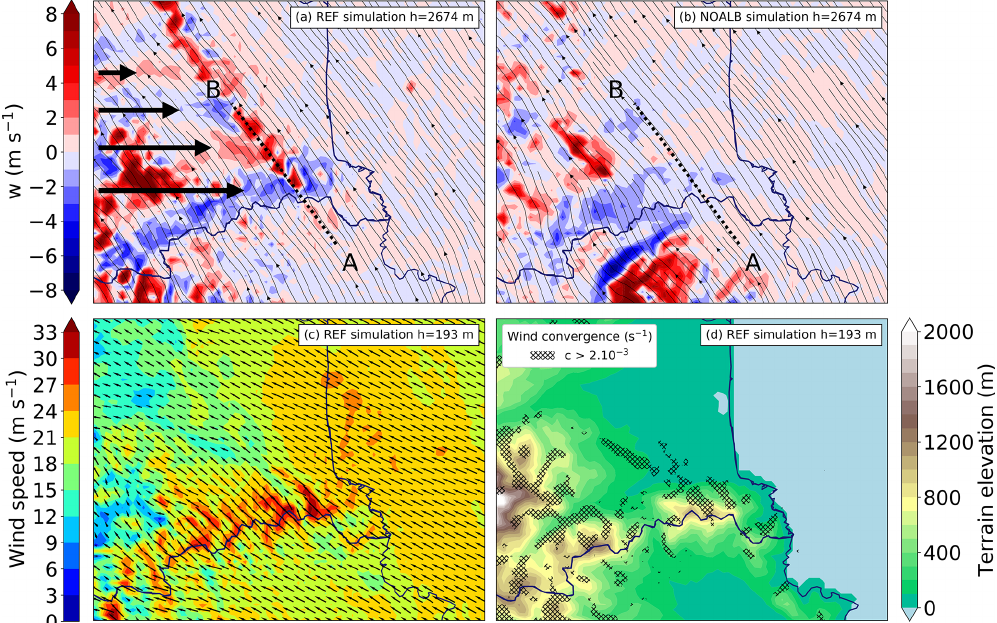
Figure 14. Vertical velocity ( w ) and horizontal wind streamlines at 2674m height in the (a) REF and (b) NOALB simulations. Horizontal wind (c) speed and direction and (d) convergence > 2 × 10 − 3 s − 1 at 193m height in the REF simulation at 05:00UTC on 15